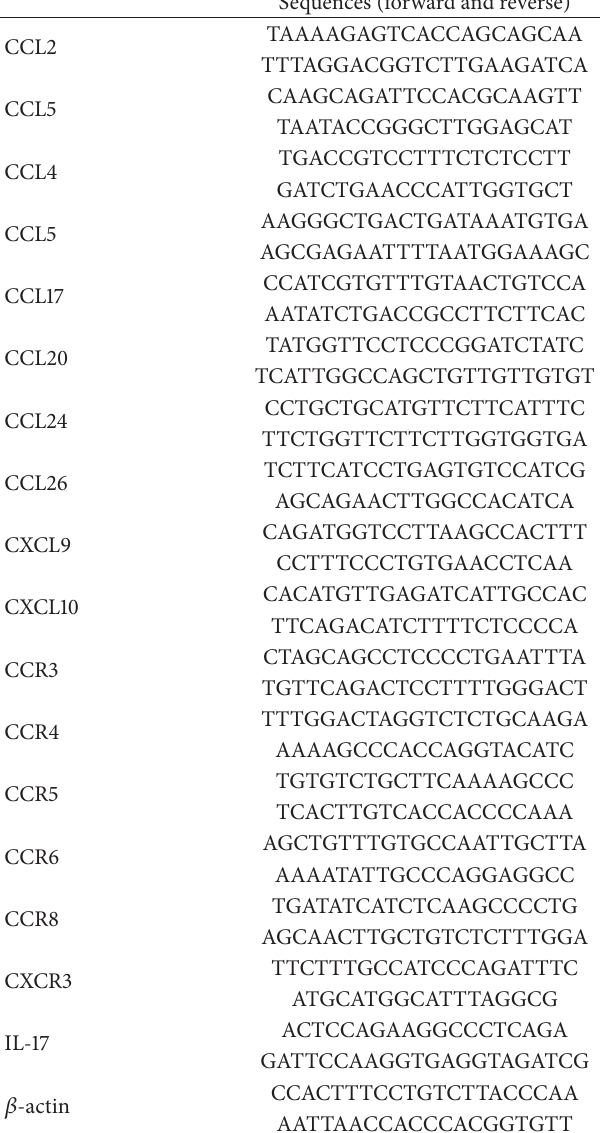
Table 1: Primer sequences according to the GenBank database. Sequences (forward and